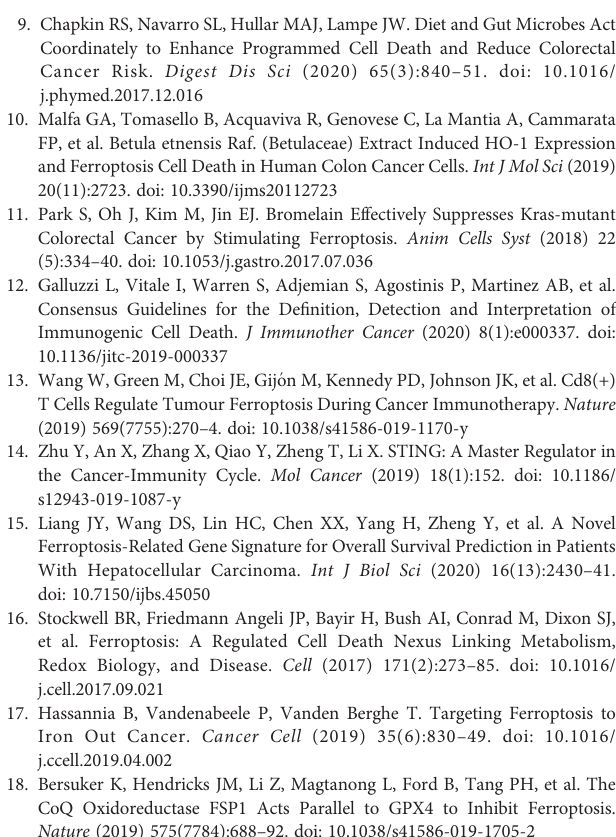
Supplementary Figure 1 | The comparison of the number of dead and alive patients between the high- and low-risk groups in two cohorts. Two bar charts indicated that the numbers of dead and alive patients were statistical different in the high and low risk groups in the TCGA (P<0.001) and GEO cohorts (P<0.01). This fi gure is related to Figures 2C, D . Supplementary Figure 2 | The survival plot, forest map and Lasso results of CD44, GCLC and MT1G in colon cancer. (A – C) The expression of CD44, GCLC and MT1G were not related to survival in colon cancer. (D) The forest map showed CD44, GCLC and MT1G were not prognostic factors in colon cancer. (E, F) The partial likelihood deviance and LASSO coef fi cient pro fi les of CD44, GCLC and MT1G were showed. Results showed CD44, GCLC and MT1G should not be included in the model, although they were signi fi cant DEGs. Supplementary Figure 3 | The riskscore was an independent prognostic factor for colon cancer patients in the GEO cohort. (A) Univariate cox regression analysis of age, gender, stage and riskscore in the GEO cohort. Riskscore is signi fi cantly associated with the survival of colon cancer patients (P<0.01). (B) Multivariate cox regression analysis of age, stage and riskscore in the GEO cohort. Riskscore is an independent prognostic factor for the survival of colon cancer patients (P<0.01). Supplementary Figure 4 | The KEGG enrichment analysis in colon cancer. The KEGG enrichment analysis between high-risk and low-risk groups in colon